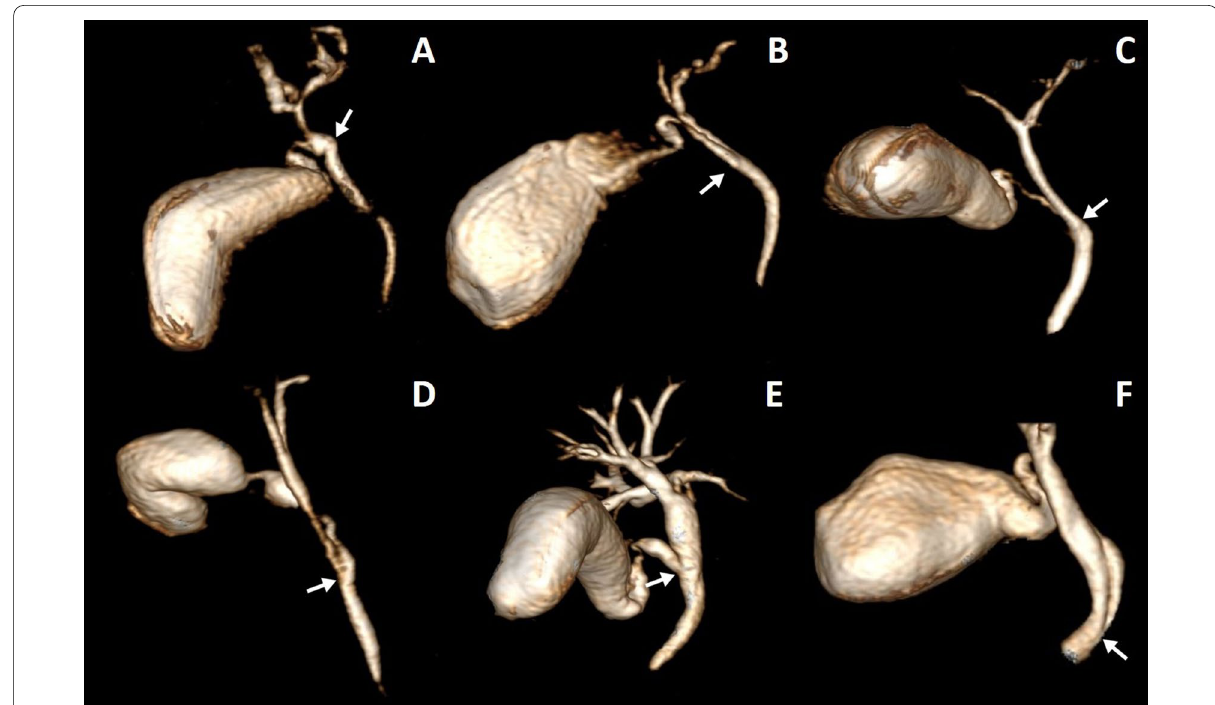
Fig. 2 The 3D volume rendering MRCP images demonstrate the high-lateral ( a ), mid-anterior ( b ), mid-posterior ( c) , mid-medial ( d ), mid-lateral ( e ), and low-medial ( f ) insertions of the cystic duct